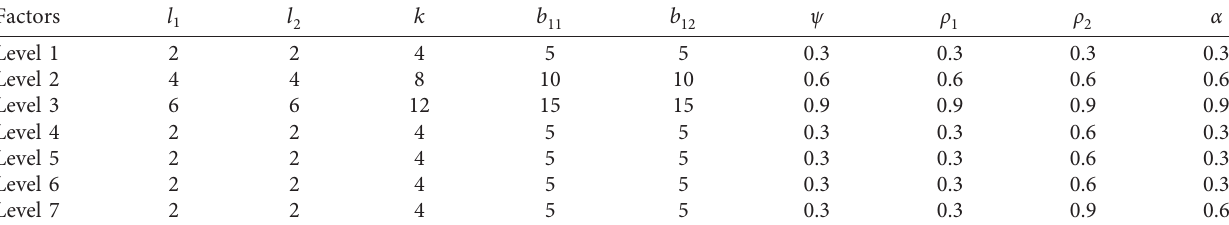
Table 2: The value range of the relevant factors.